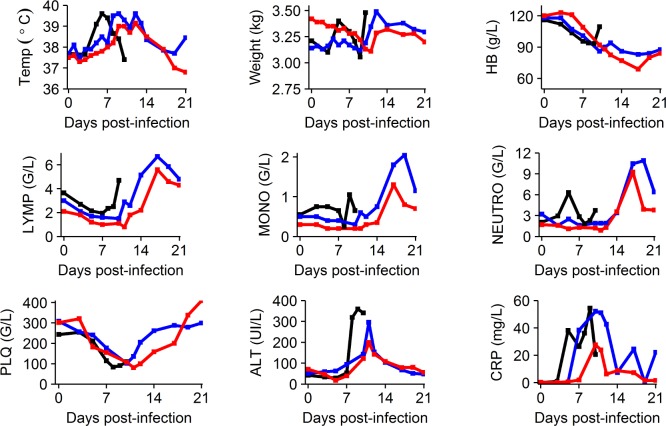
Clinical, biochemical, and hematological evolution according to the dosing group.Median values are shown for the following parameters: temperature (Temp), weight, hemoglobin (HB), lymphocyte count (LYMP), monocyte count (MONO), neutrophil count (NEUTRO), platelets (PLQ) (giga/l [G/L]), alanine aminotransferase (ALT), and C-reactive protein (CRP). Black: untreated; blue: 150 mg/kg BID; red: 180 mg/kg BID. More parameters are available in S2 Fig. Given the limited number of data available, animals treated with 100 mg/kg BID are not represented.